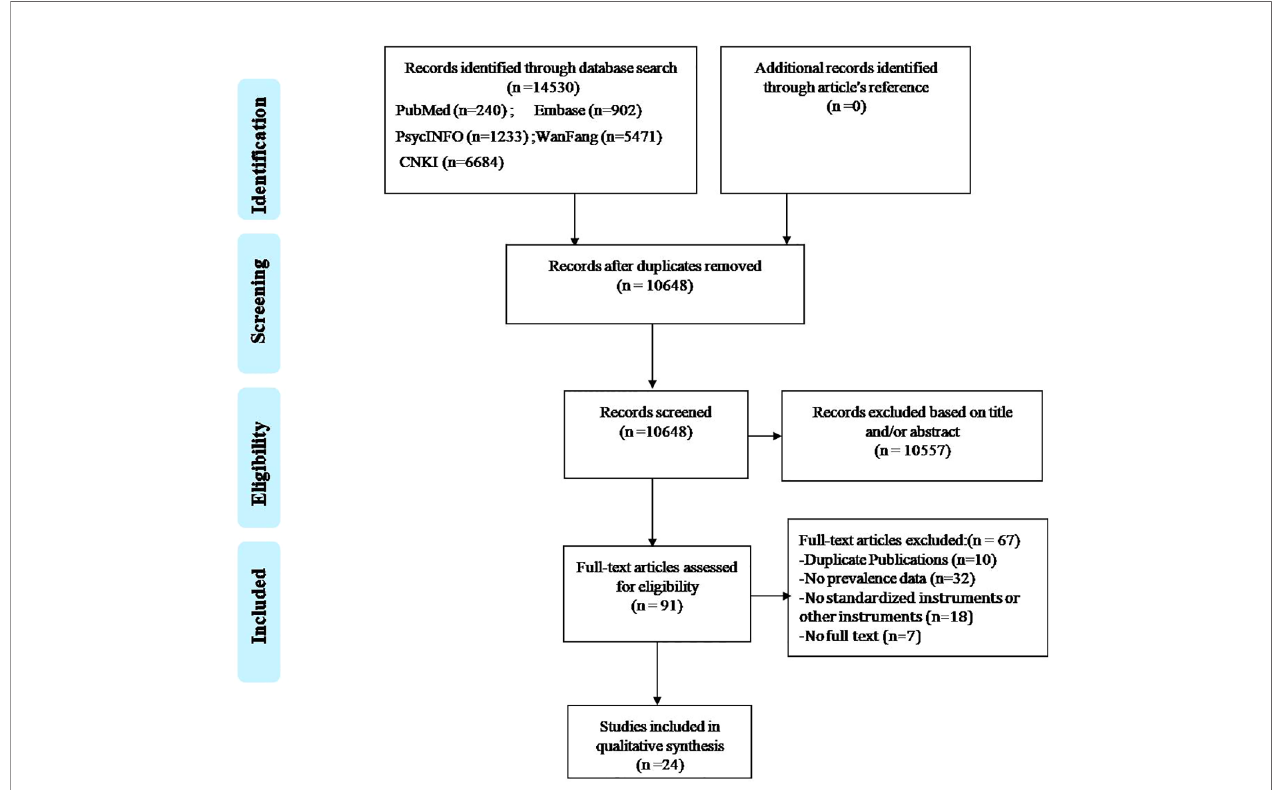
FIGURE 1 | PRISMA fl